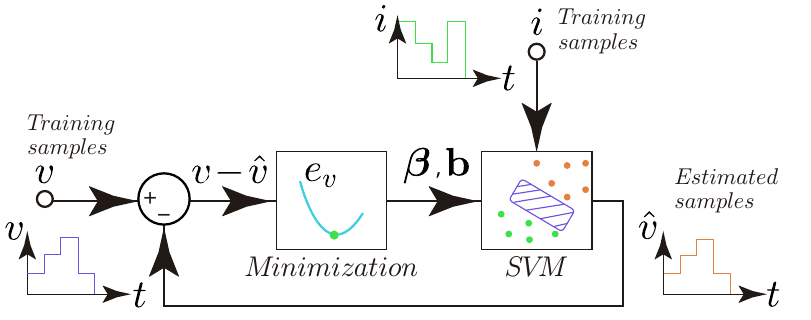
Figure 1. Conceptual illustration of the SVM